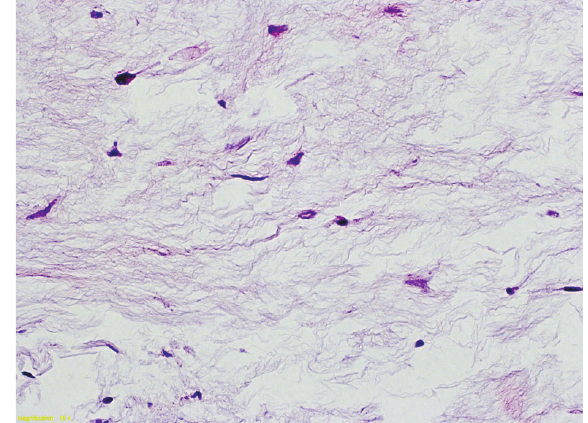
Figure 7: At higher magnification, fusiform cells of little size and regular shape are seen. Elongated aspect nuclei are present, without mitotic